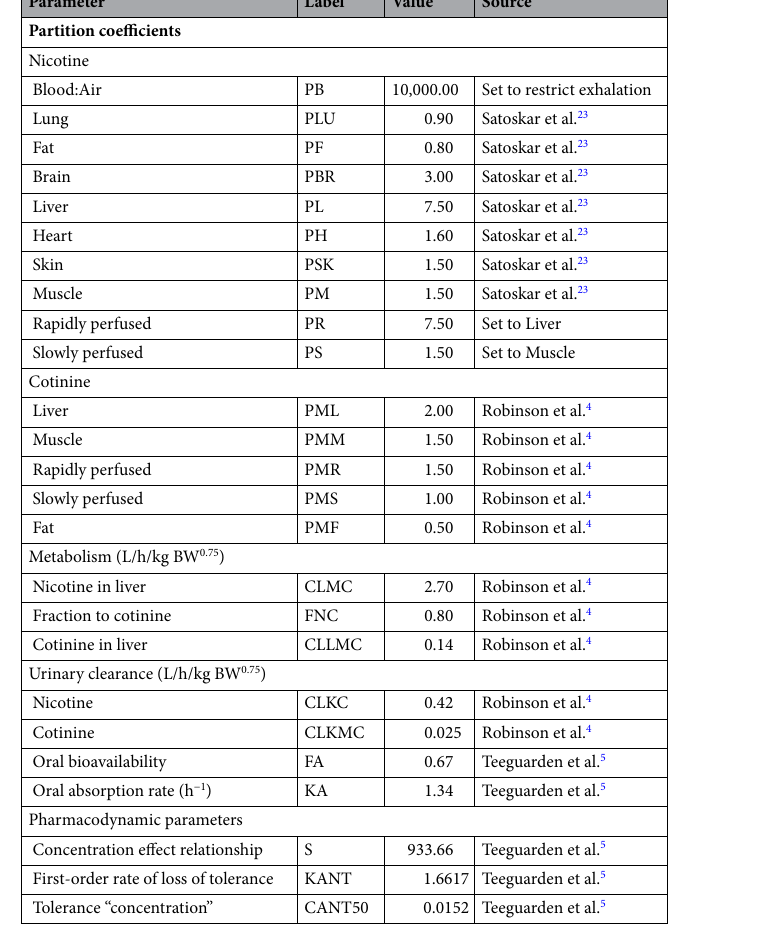
Table 2. Chemical specific parameters for the human nicotine PBPK model 4,5,23